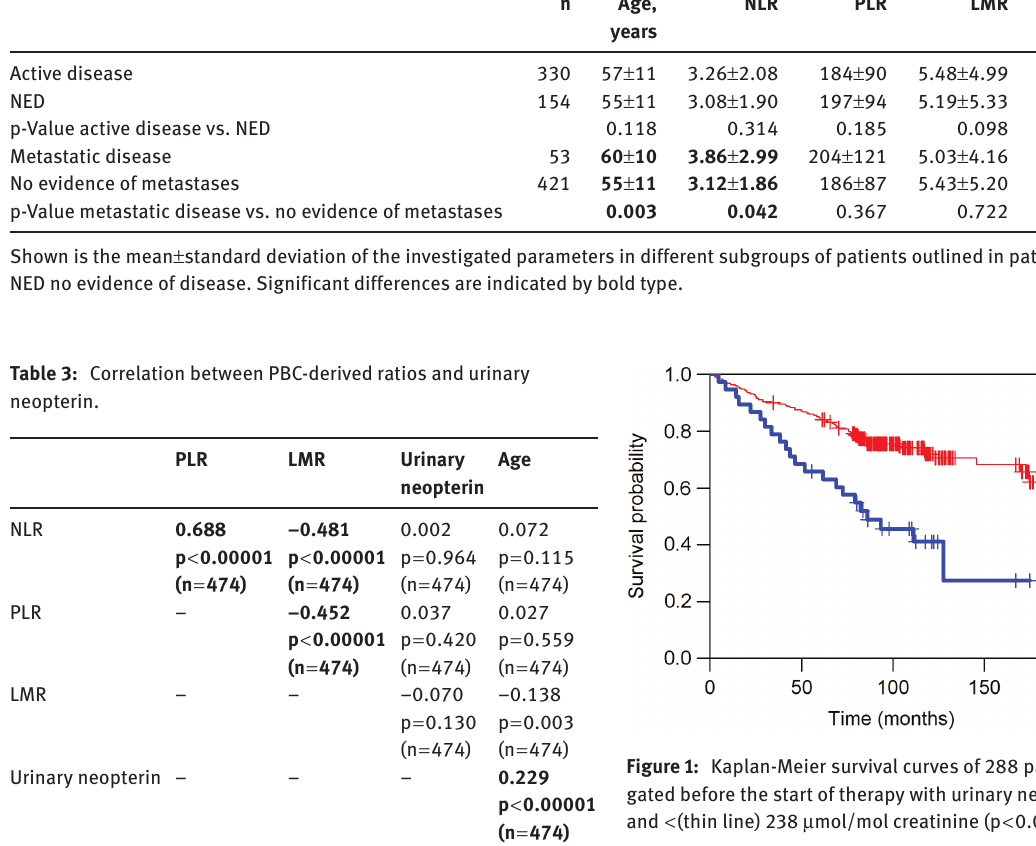
Table 2: Urinary neopterin and PBC-derived ratios in patients according the presence of active disease and distant metastases. Subgroup